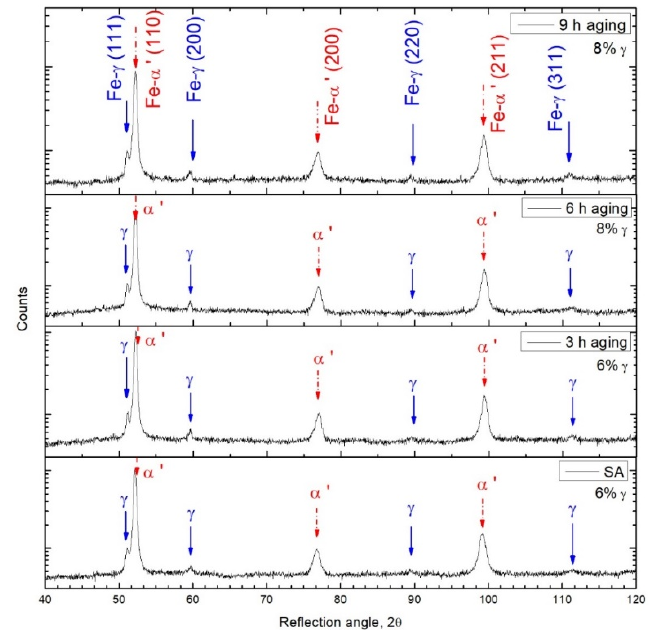
Figure 6. X-ray diffraction patterns for the solution annealed and aged samples. Table 3. XRD diffraction pattern parameters.